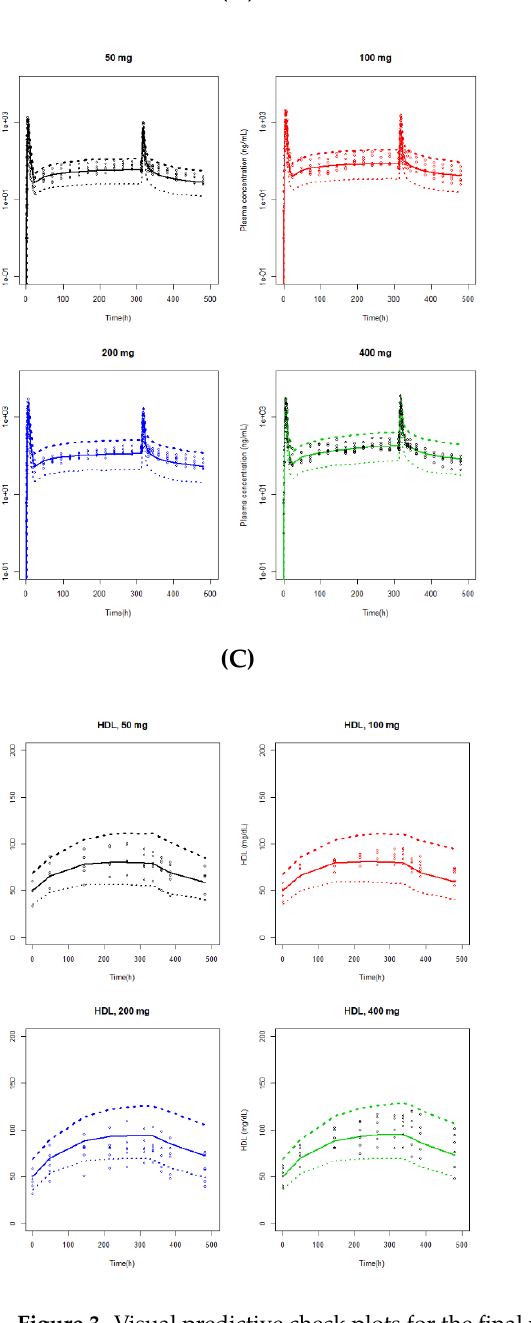
Figure 3. Visual predictive check plots for the final pharmacokinetic and pharmacodynamic models: ( A ) PK model; ( B ) CETP model; ( C ) HDL-C model; ( D ) LDL-C model. Open circles are the observations. The upper and lower dashed lines are the 95th and 5th percentiles of the simulated data based on 1000 simulations, respectively. The solid line is the median of the simulated data. Black line is line of identity, and gray line is locally weighted regression smooth line. IWRES, individual weighted